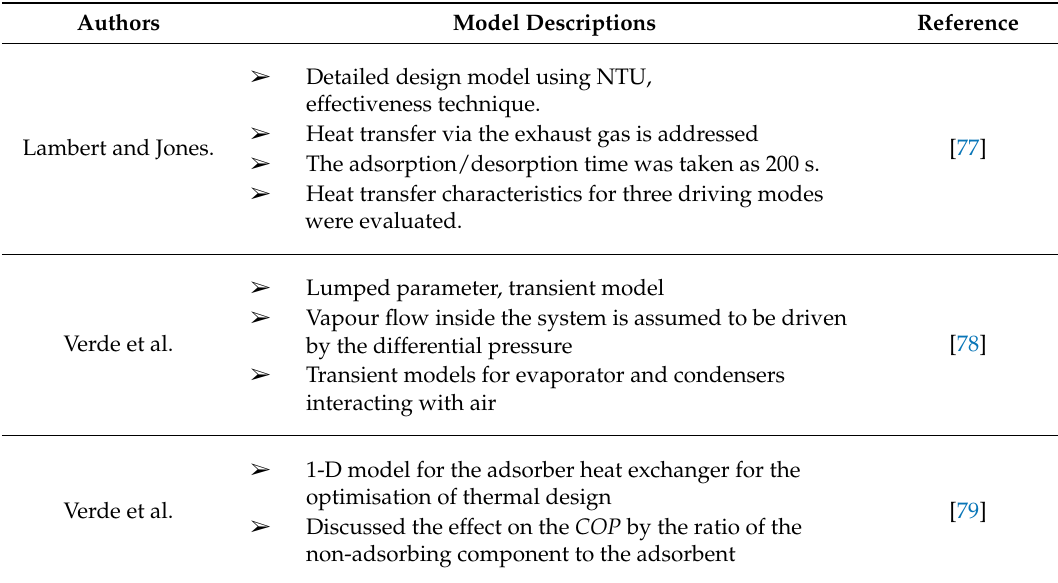
Table 5. List of modeling work relevant to automobile air conditioning using adsorption